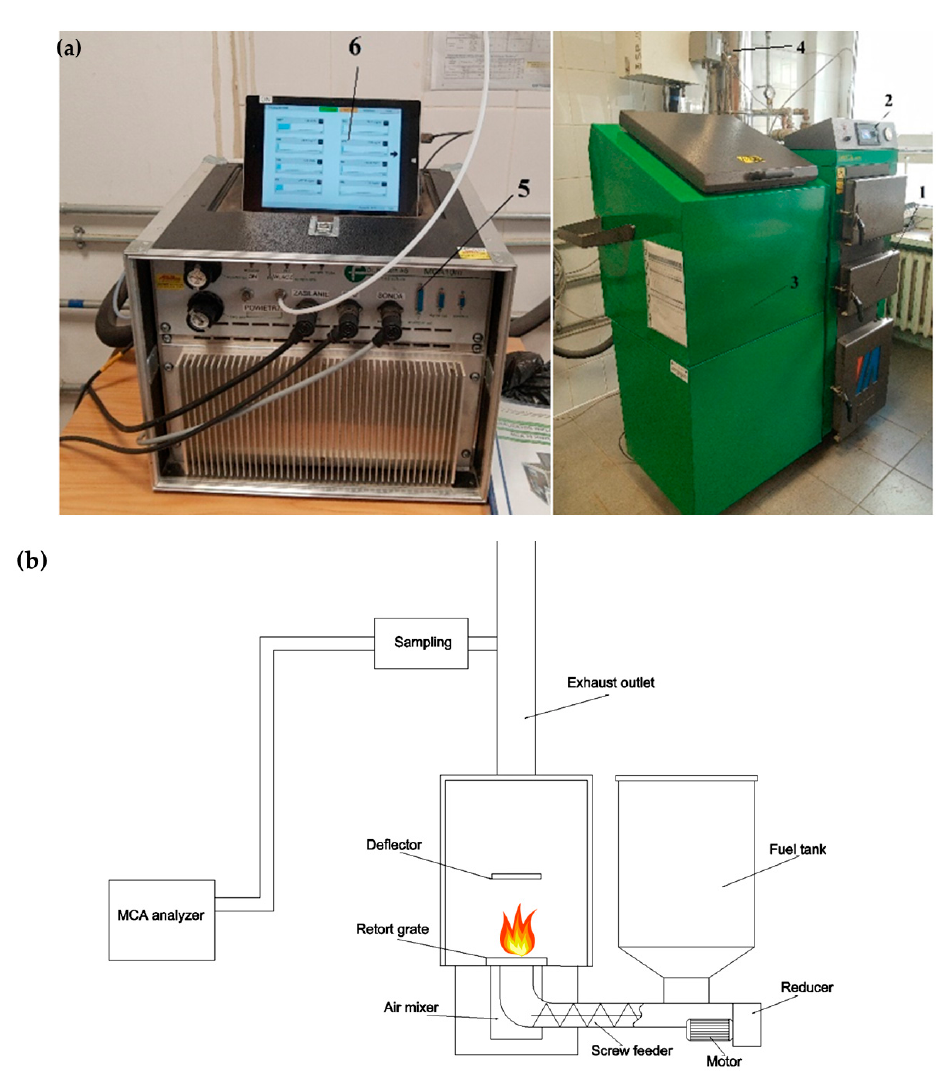
Figure 1. Laboratory combustion setup: ( a ) 1—Unica VentoEko boiler (Moderator, Poland), 2—boiler controller, 3—fuel tank, 4—exhaust gas sampling point, 5—MCA10 analyzer, 6—tablet for archiving measurements (authors’ graphs), and ( b ) scheme of the setup (authors’ graphs).